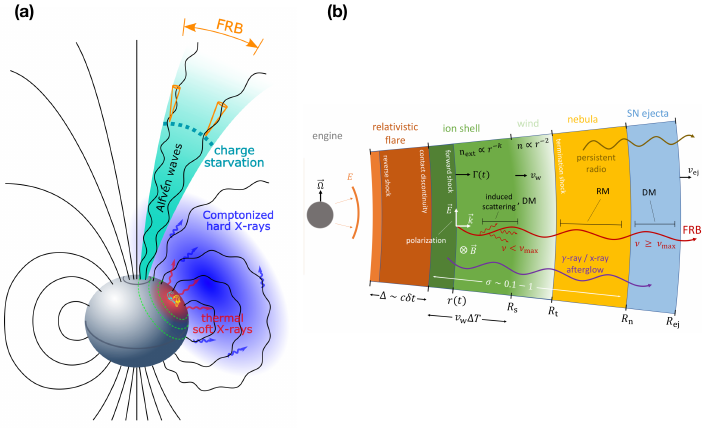
Figure 4. Left panel: Figure 2 (left panel) from [78] “A unified picture of Galactic and cosmological fast radio bursts”, reproduced with permission from Wenbin Lu, published by MNRAs (RAS Publishing), 2020. Right panel: Figure 1 from [86] “Fast radio bursts as synchrotron maser emission from decelerating relativistic blast waves”, reproduced with permission from Brian Metzger, published by MNRAS (RAS Publishing), 2019. A comparison of the two most general scenarios for magnetar models: ( a ) pulsar-like or magnetospheric models; ( b ) GRB-like or external models. See text for